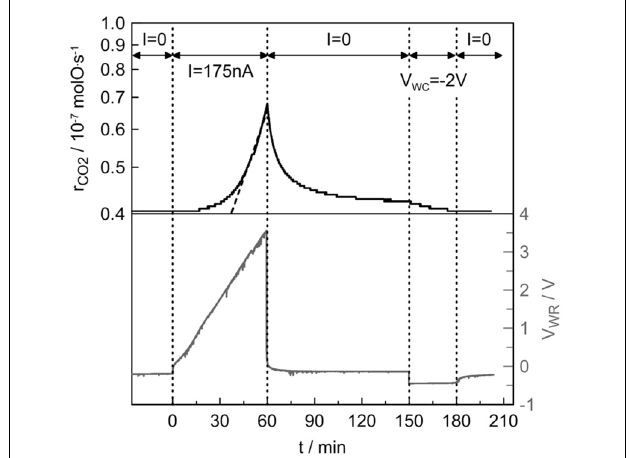
FIGURE 3 | Catalytic rate and potential responses to step changes of a small ( + 175nA ) current application and a negative ( − 2V) potential imposition during C 3 H 8 oxidation on Pt/ β (cid:2)(cid:2) -Al 2 O 3 (Ag + ) at 375 ◦ C. Reactive mixture: C 3 H 8 /O 2 : 2400ppm/1.2%. Overall flow: